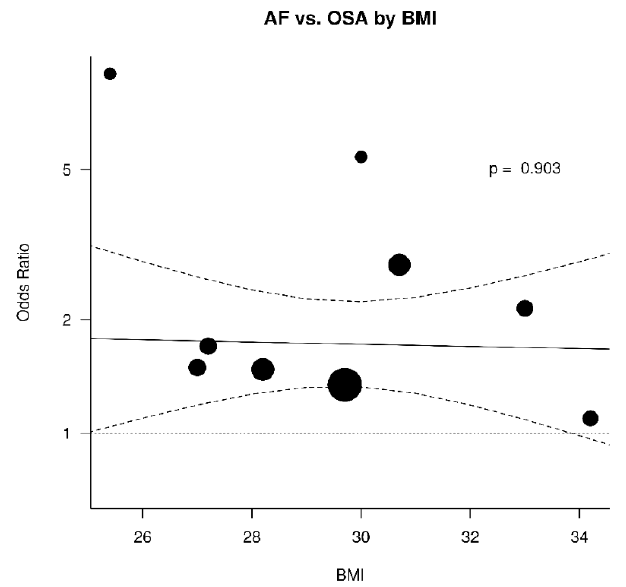
Figure 6. Effect of body mass index (BMI) in the odds ratio for atrial fibrillation (AF) in patients with obstructive sleep apnea (OSA).